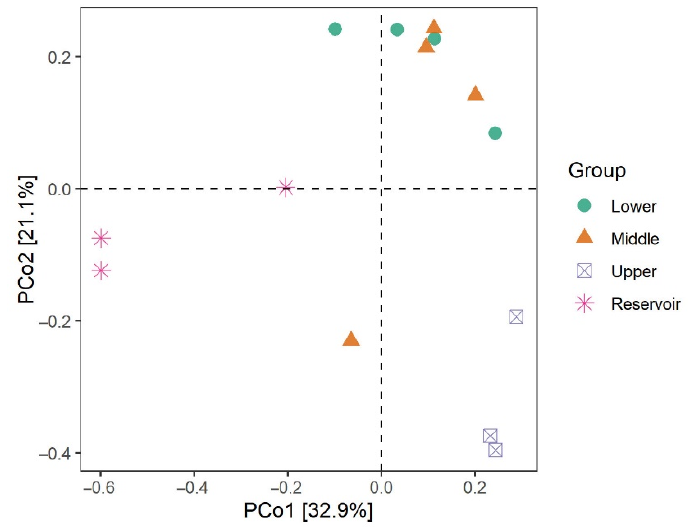
Figure 6. Principal coordinate analysis (PCoA) plots of bacterial communities in the water.